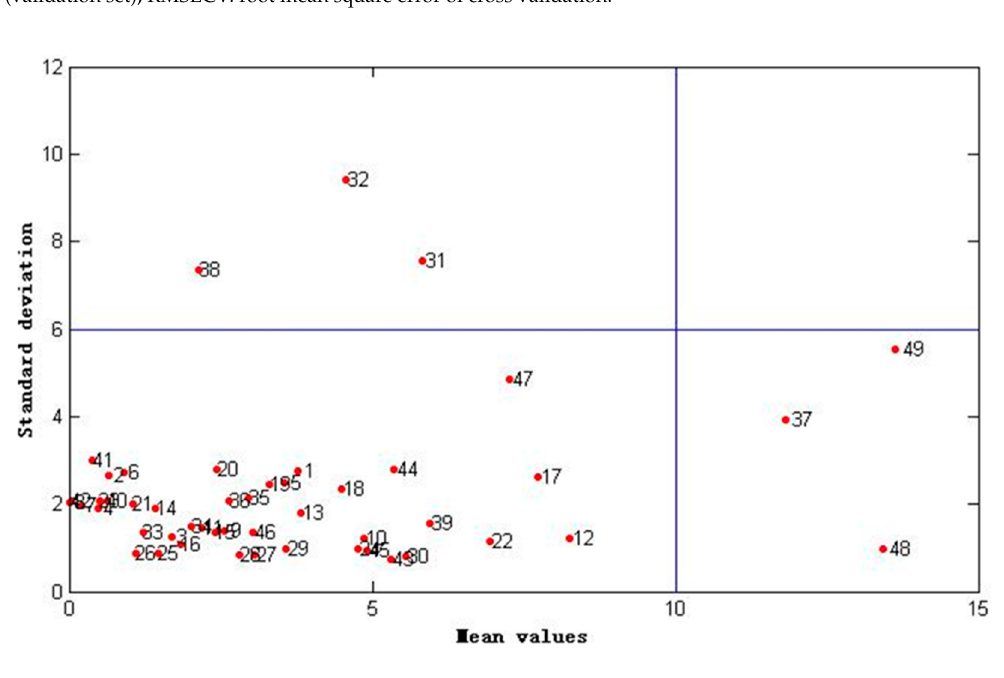
Figure 2. Distribution of the predicted mean and standard deviation values of 2,2-diohenyl-1-picryl-hydrazyl (DPPH) radical scavenging assay for 49 ATR samples by Monte-Carlo cross-validation (MCCV) method. A 2000-time Monte-Carlo sampling was conducted for the dataset of all samples (49 ×